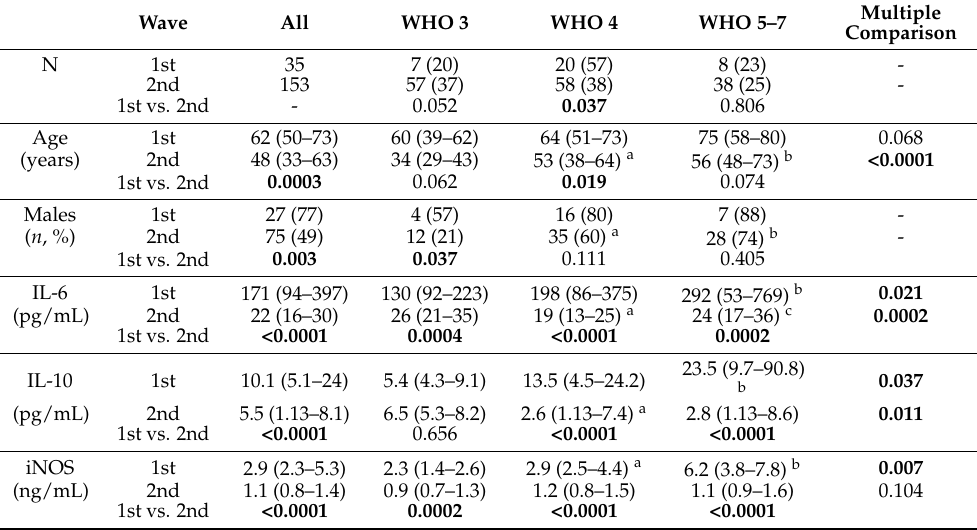
Table 1. Comparison of serum cytokine levels and iNOS in COVID-19 patients from the 1st wave ( n = 35) and 2nd wave ( n = 153) at admission, stratified according to the worst WHO stage. Median and interquartile